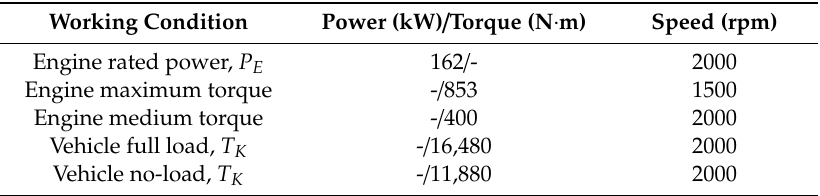
Table 4. Working conditions of the wheel